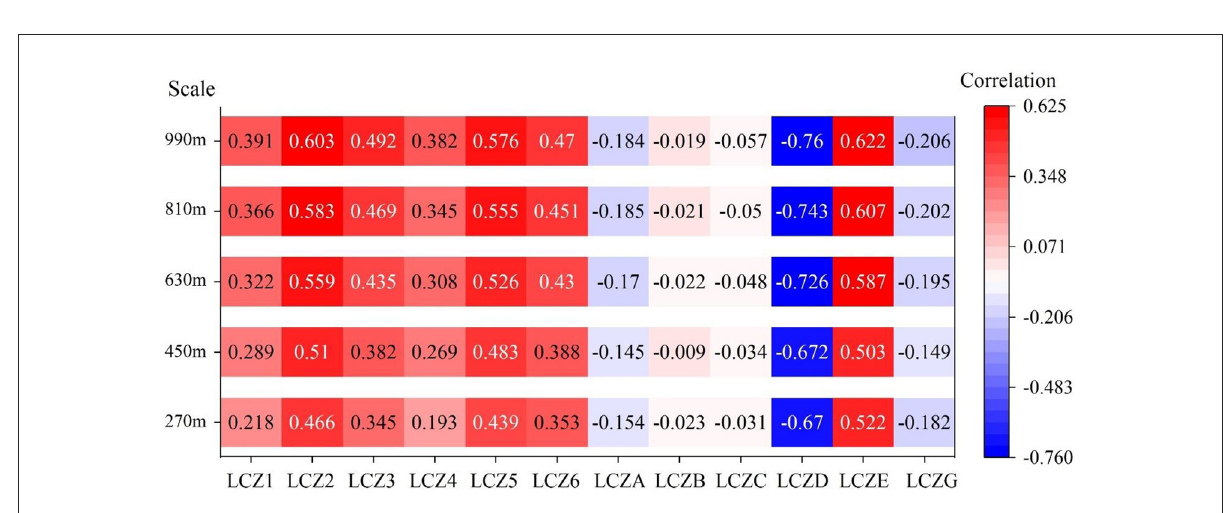
FIGURE6 Correlation coefficients between LCZ and LST at different first-level grid scales.